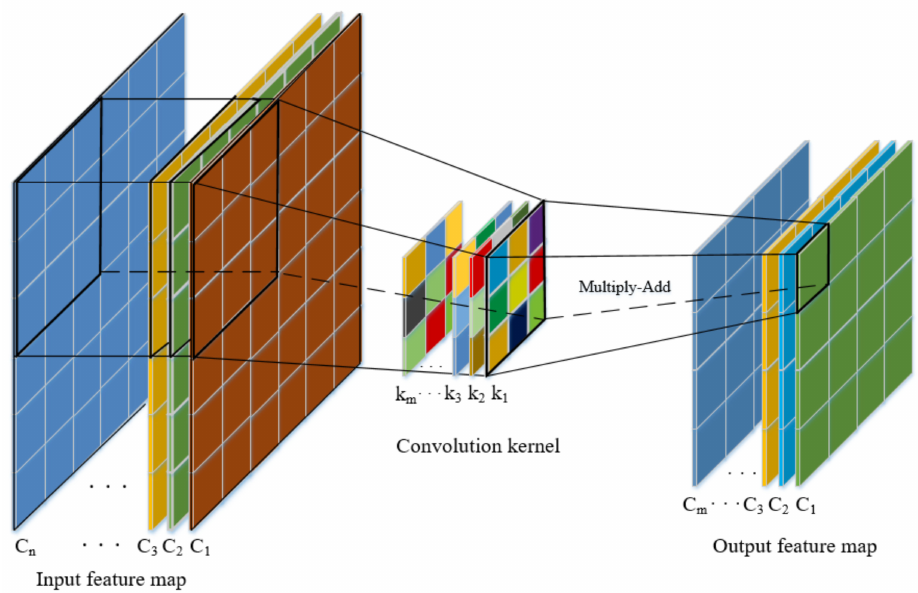
Figure 10. Schematic diagram of the conventional convolution (C is feature channel, k is convolution